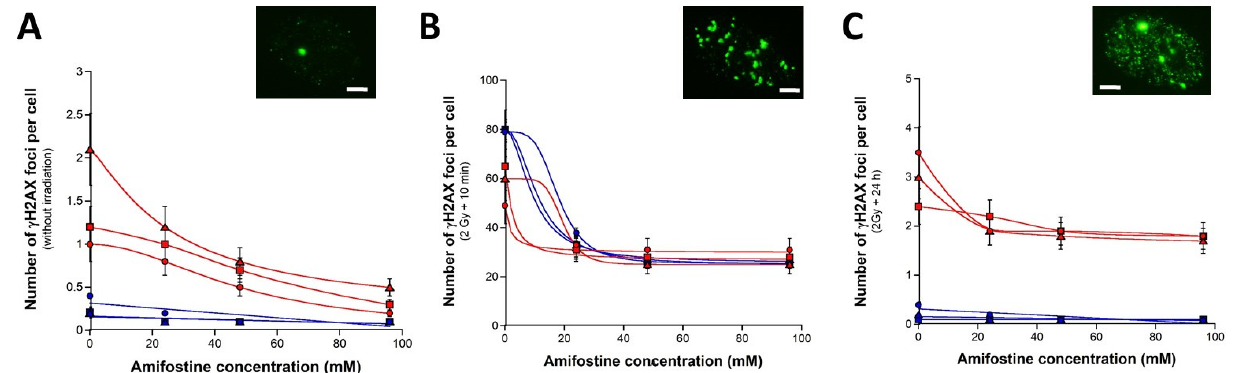
Figure 3. Radioprotective effect of a pretreatment with amifostine. Number of γ H2AX foci per cell in the human untransformed radioresistant AG1521 (blue squares), 1BR3 (blue triangles) and 149BR (blue circles) fibroblasts and in the radiosensitive 09CLB (red triangles), 11CLB (red squares) and 15CLB (red circles) fibroblasts after pretreatment with amifostine ( A ), followed by 2 Gy X ‐ rays and 10 min ( B ) or 24 h ( C ) incubation. Each point represents the mean ± standard error (SEM) of at least three replicates. Exponential, sigmoidal or linear functions were used for data fitting. Inserts show representative examples of 96 mM pretreated 09CLB nuclei with γ H2AX foci assessed at the indicated conditions. White bar represents 5 μ m.